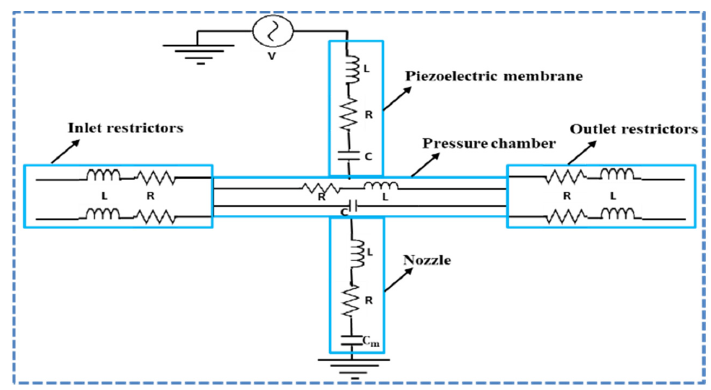
Figure 1. Equivalent circuit of a recirculating piezoelectric inkjet printhead.